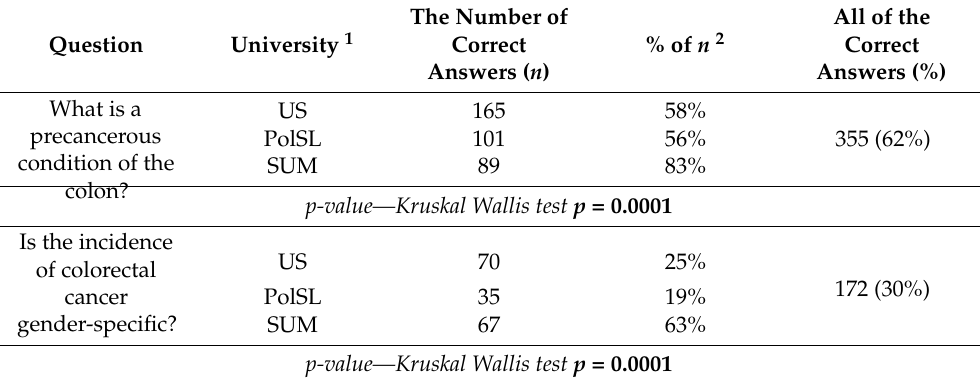
Table 3. Number of correct answers given by respondents to questions about colorectal cancer depending on the university from which they came. (Single-choice questions). Source: own